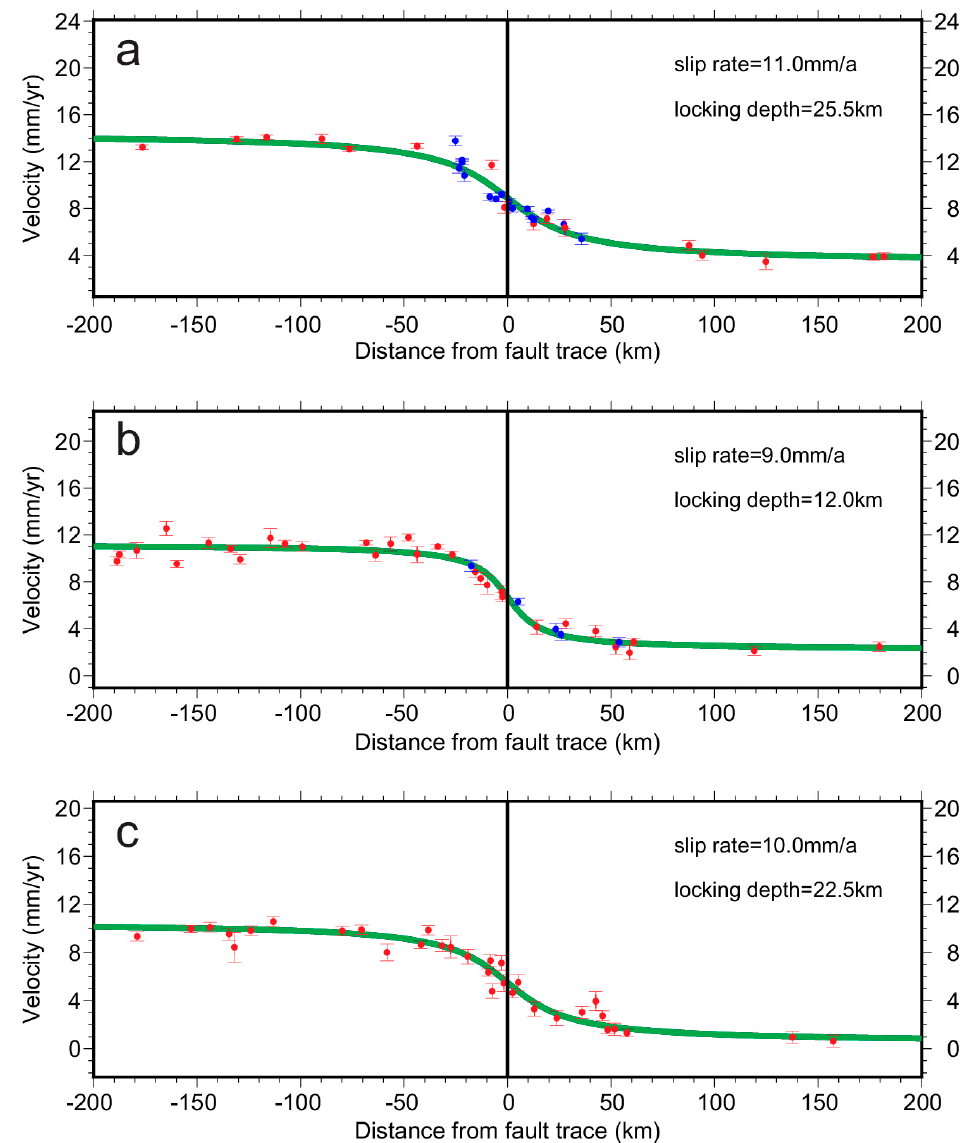
Figure 3. The observed GNSS velocity component parallel to the orientation of the Xiaojiang fault along the profiles (profiles a, b and c) shown in Figure 2 and the determination of the slip rates by the traditional dislocation model. The green curves are the results of fitting, the blue value is our velocity projection result, and the red value is the previous velocity projection result. ( a ) The profile across the northern segment; ( b ) the profile across the central segment; ( c ) the profile across the southern